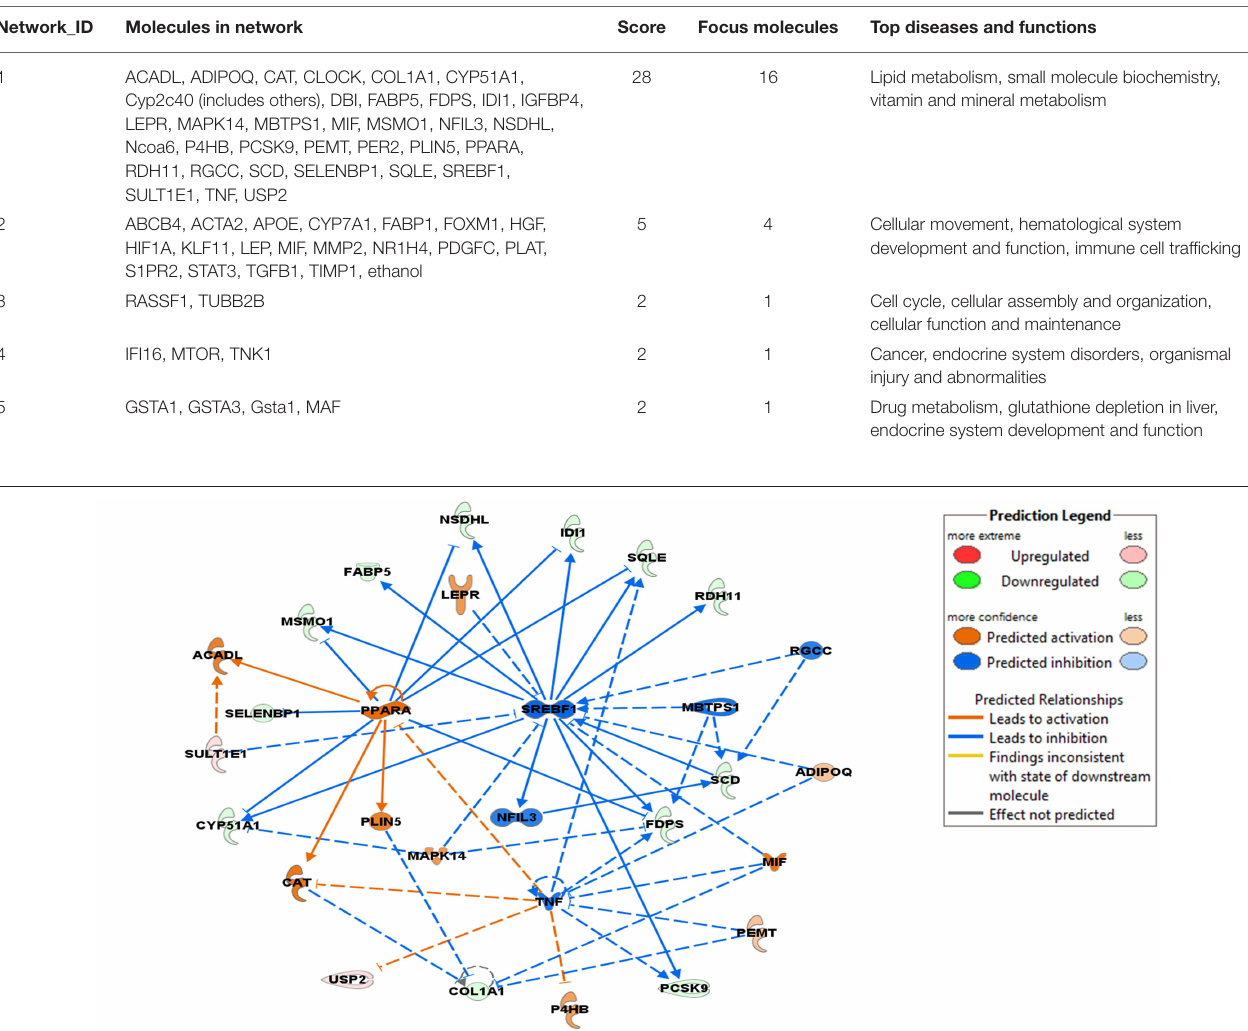
catabolism. But dramatic depletion of Phb1 is no capable of preventing impaired lipid metabolism and rapidly exacerbates liver